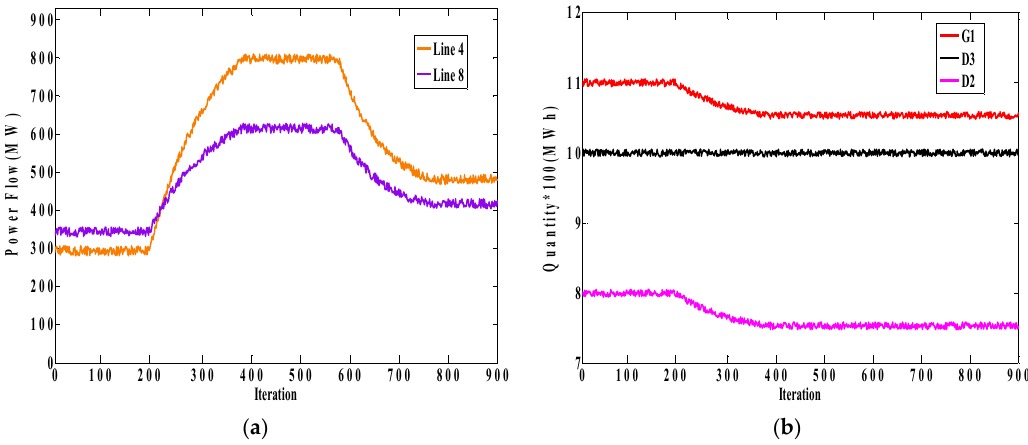
Figure 15. ( a ) Power flows of Lines 4 and 8 in Case B when the limit of Line 4 increases; ( b ) bidding quantity of G1, D2, and D3 in Case B.